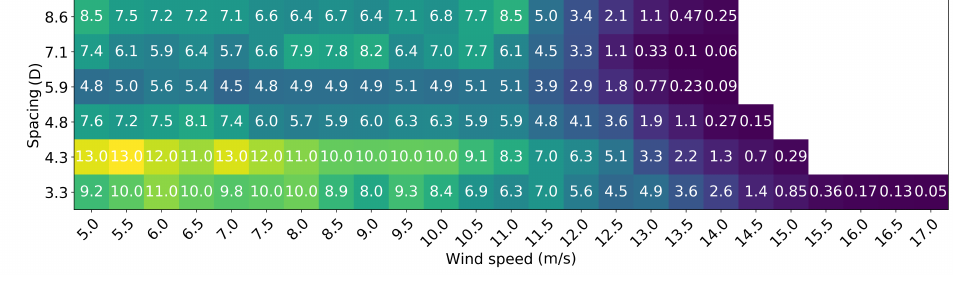
Figure 8. Heatmap showing the average of the mean average percentage error for turbine spacing and wind speed